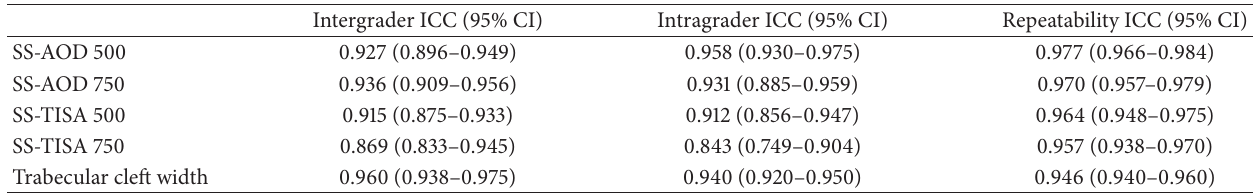
Table 3: Intraobserver and interobserver reproducibility and repeatability measurement of angle parameters with the swept source